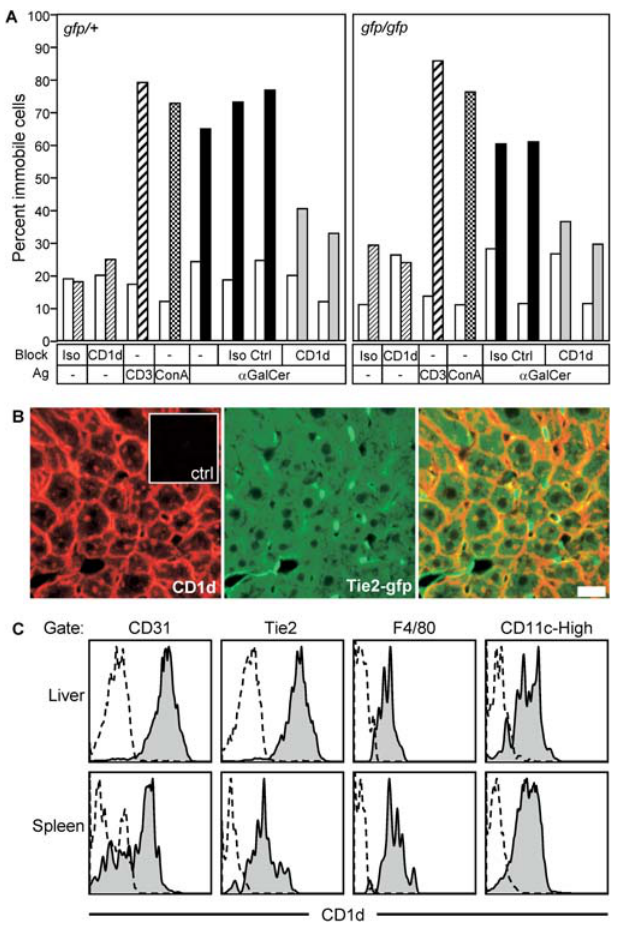
Figure 3. CXCR6 þ Lymphocytes Stop Patrolling upon TCR Activation (A)ActivationofNKTcellsdeliversstopsignal. cxcr6 gfp/ þ and cxcr6 gfp/gfp mice were imaged before and after intravenous injection of antibody, lectin, or glycolipid antigen. Percentage of immobile cells was determined in 6-min videos either before any injection or 40 min after antigen delivery. (B) Histological examination of hepatic CD1d expression. Liver tissue from a Tie2-GFP transgenic was stained with anti-CD1d antibody (left panel, red) or an isotype control (inset). Green fluorescence indicates sinusoid-lining endothelial cells (expressing GFP) as well as the highly autofluorescent hepatocytes. (C) Flow-cytometric examination of hepatic CD1d expression. Cells isolated from liver tissue were stained with antibodies to endothelial cell markers (CD31 and Tie2), a Kupffer cell marker (F4/80), or a dendritic cell marker (CD11c) while co-stained with anti-murine CD1d (filled-in) or an isotype-matched control (dashed line). DOI: 10.1371/journal.pbio.0030113.g003